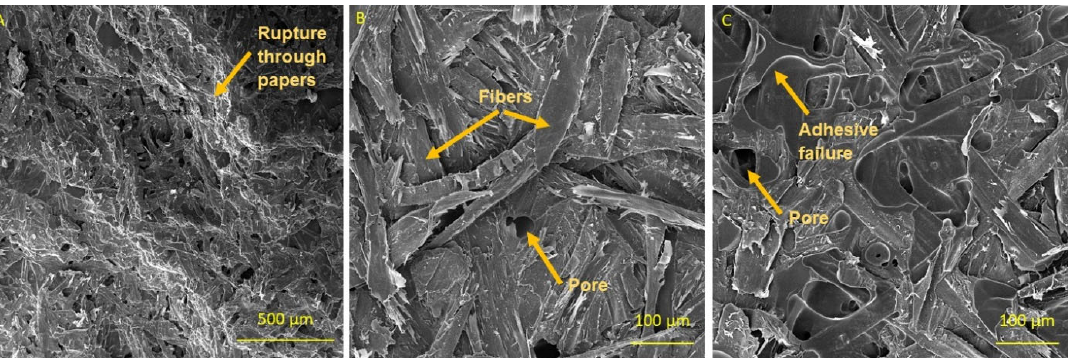
Figure 6. SEM of ruptured samples showing the character of bond rupture: ( A ) L ‐ LPF ‐ 1 variant, magnification 150×; ( B ) L ‐ LPF ‐ 1 variant, magnification 500×; ( C ) L ‐ LPF ‐ 5 variant, magnification 500×.